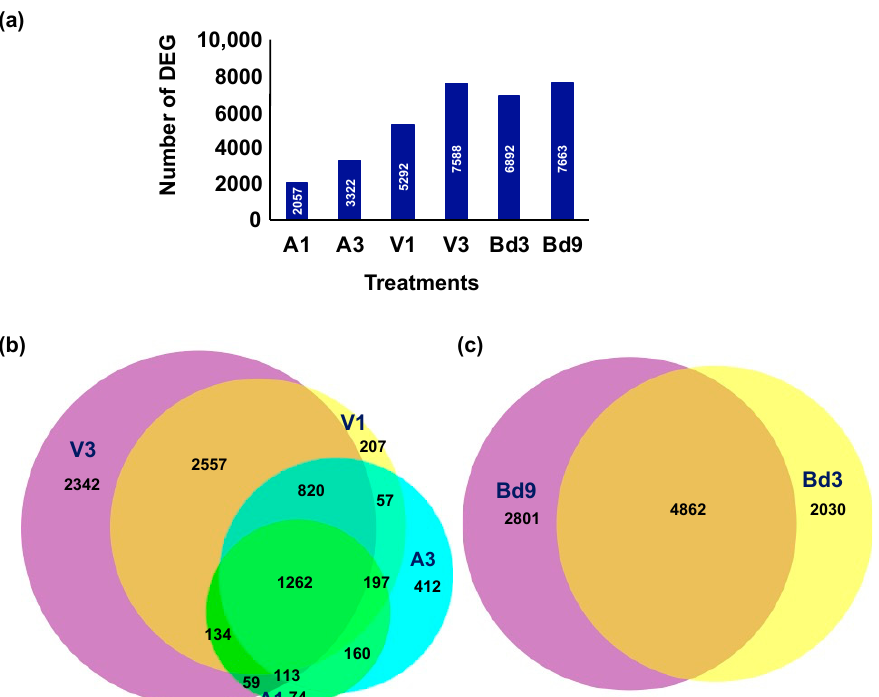
Figure 1. Differential expression of genes in Hessian fly larvae feeding on host wheat and nonhost Brachypodium distachyon (Bd) plants. Differentially expressed genes (DEG) were identified from avirulent (A) and virulent (V) Biotype L Hessian fly larvae feeding on host wheat at 1 (A1, V1) and 3 (A3, V3) days after egg hatch (DAH) as compared to the neonates, and Biotype L larvae feeding on nonhost Bd plants at 3 (Bd3) and 9 (Bd9) DAH as compared to neonates. ( a ) Number of statistically significant DEG (with log2 expression >1 or < − 1 and adjusted p -value < 0.05) in A1, A3, V1, V3, Bd3, and Bd9 larvae. ( b ) Venn diagram depicting shared and uniquely expressed DEG between avirulent and virulent Biotype L larvae feeding on host wheat at 1 and 3 DAH. ( c ) Venn diagram depicting shared and uniquely expressed DEG between Biotype L larvae feeding on nonhost Bd plants at 3 and 9 DAH.